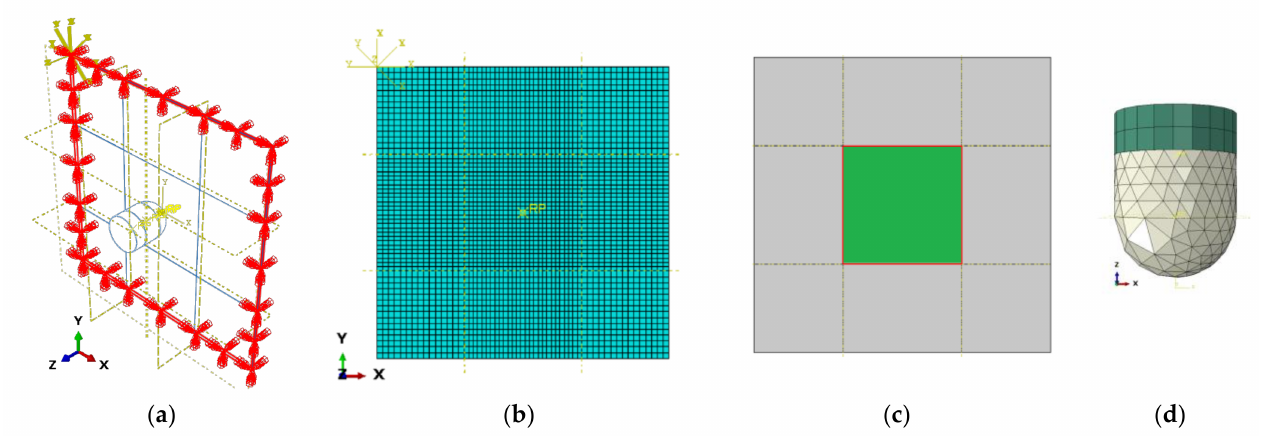
Figure 10. Model ( a ) boundary conditions, ( b ) single ply mesh, ( c ) inter-ply tie constraints and cohesive zone contact interface regions, and ( d ) two degree of freedom impactor